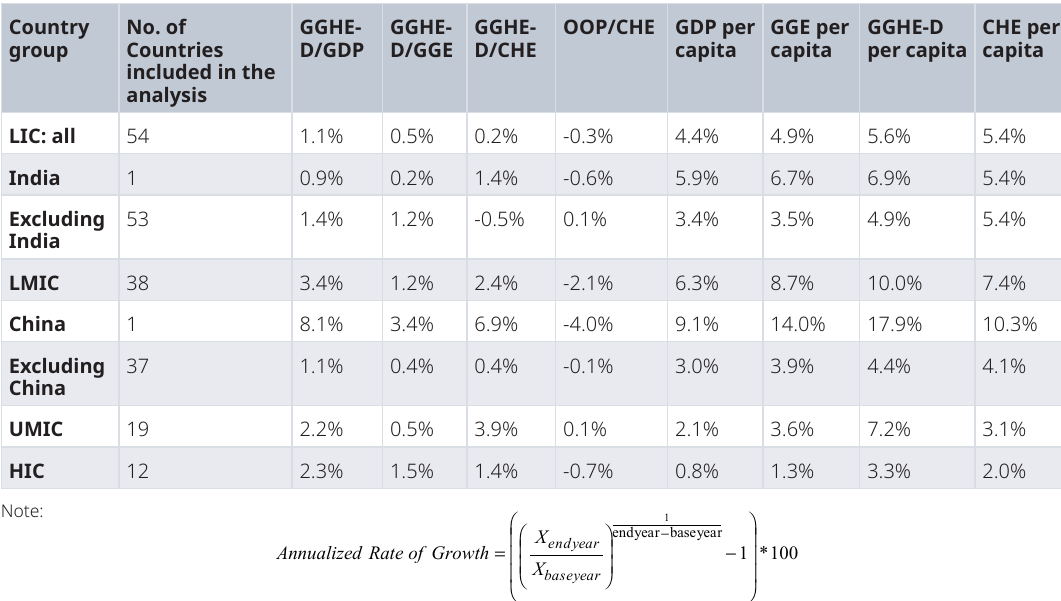
Table 4. Annual rate of growth, key ratios and per capita values, 2000 to 2015. Country